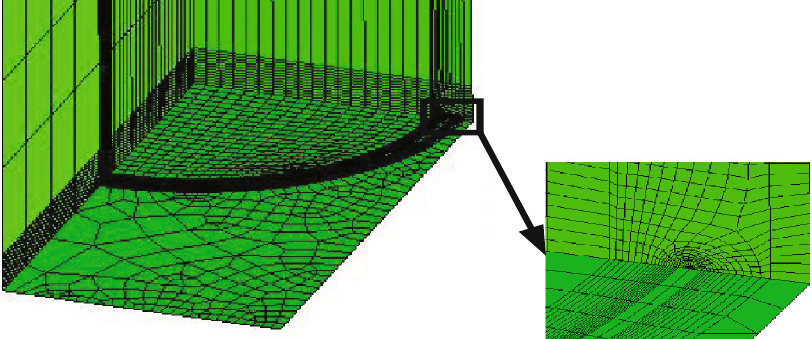
Figure 2: Typical fi nite element mesh.